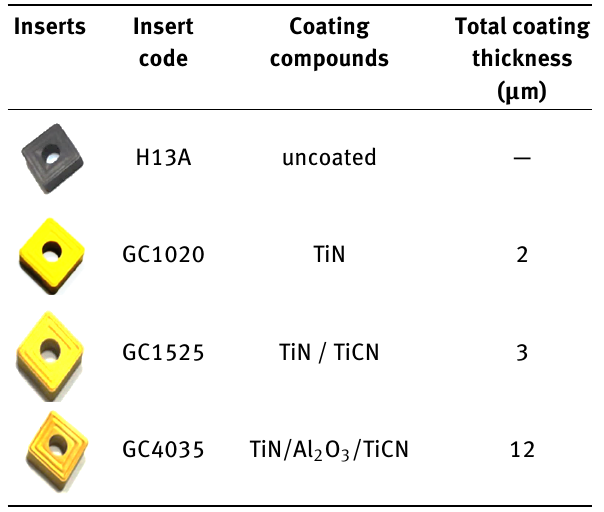
Table 1: Some specifications for different cutting tools according to the general information of Sandvik Coromant Company [19]